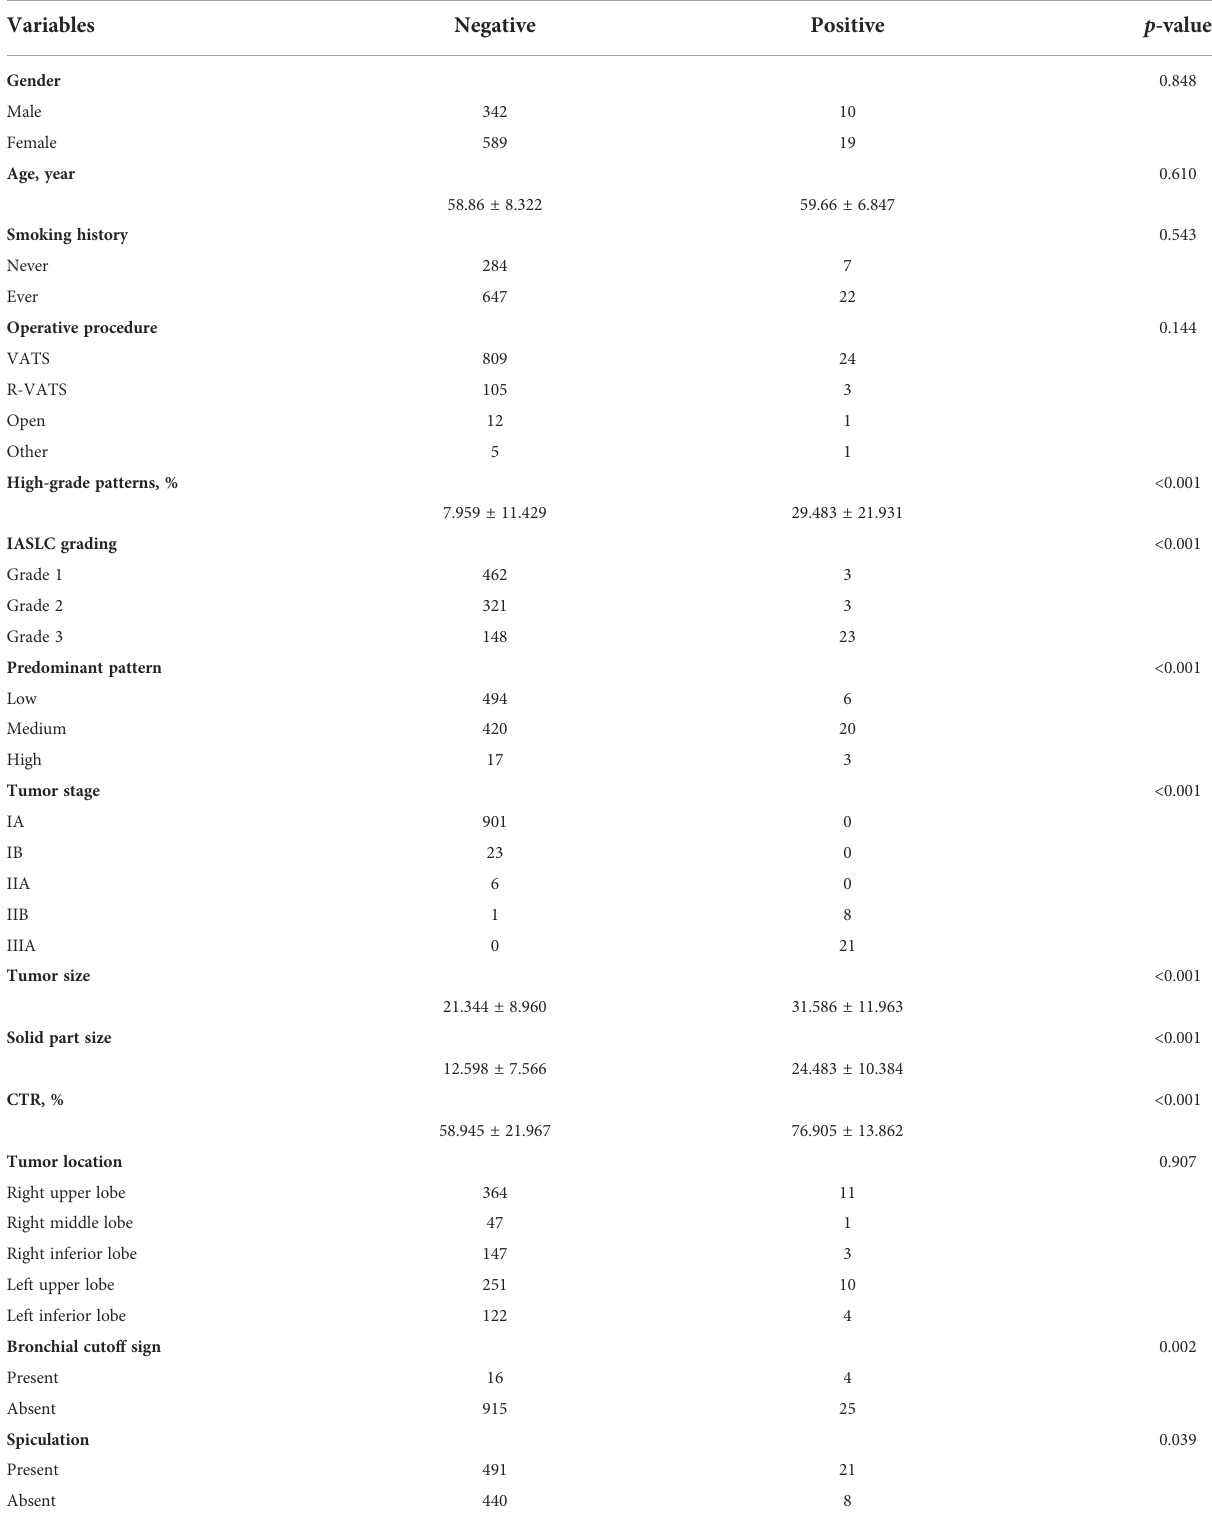
TABLE 1 Relationship between clinicopathologic characteristics and lymph node metastasis in all patients (N =